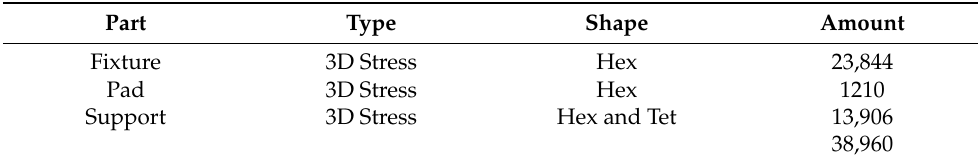
Figure 4. Numerical analysis model. Table 1. The total elements used. Table 1. The total elements used.